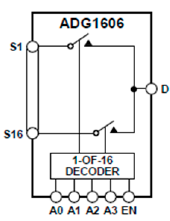
Figure 4. Functional block diagram of the ADG1606 multiplexer.